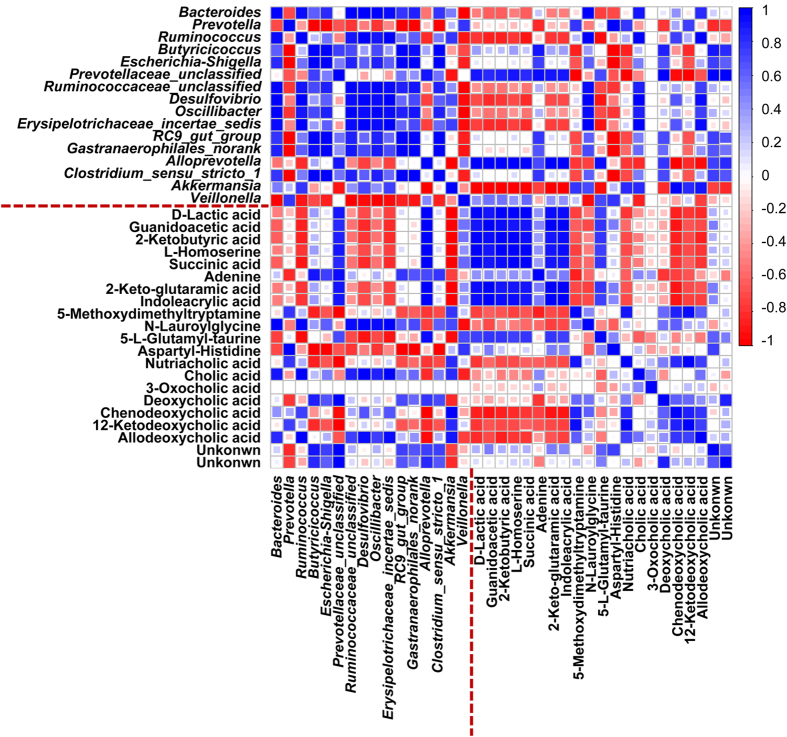
A correlation heatmap is used to represent significant statistical correlation values (r) between perturbed gut microbiota genera and altered fecal metabolites in antibiotic group and control group.Blue squares indicate significant positive correlations (r > 0.5, p < 0.05), white squares indicate nonsignificant correlations (p > 0.05), and red squares indicate significant negative correlations (r < −0.5, p < 0.05).